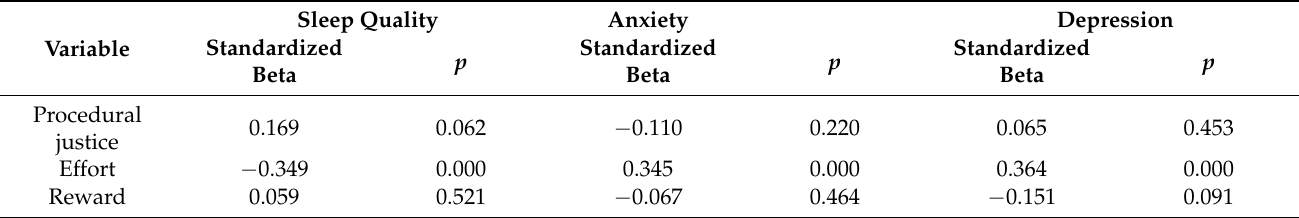
Table 5. Second wave. Health outcomes associated with procedural justice and occupational stress. Linear regression analysis adjusted for age and gender.